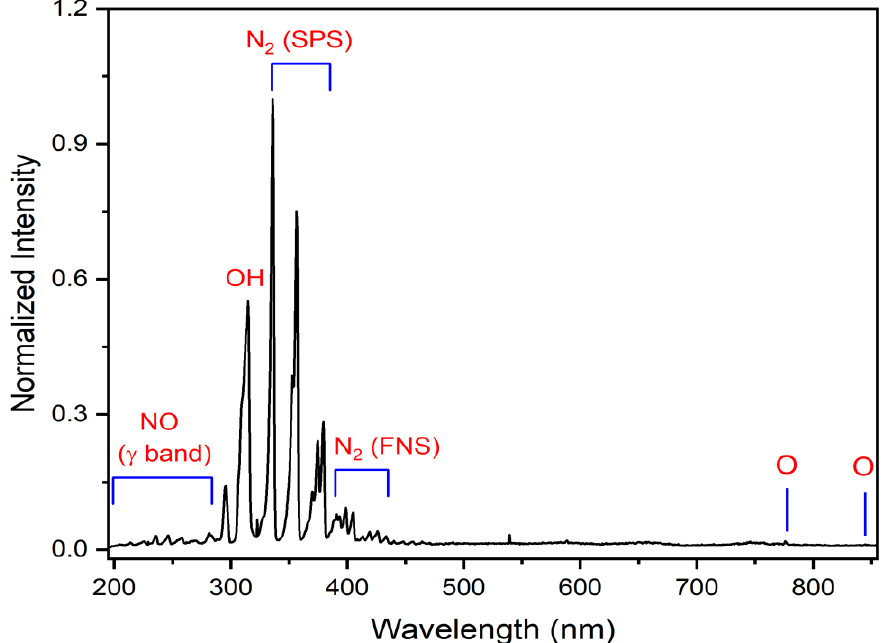
Figure 4. Optical emission spectrum of gliding arc discharge in the ambient air.